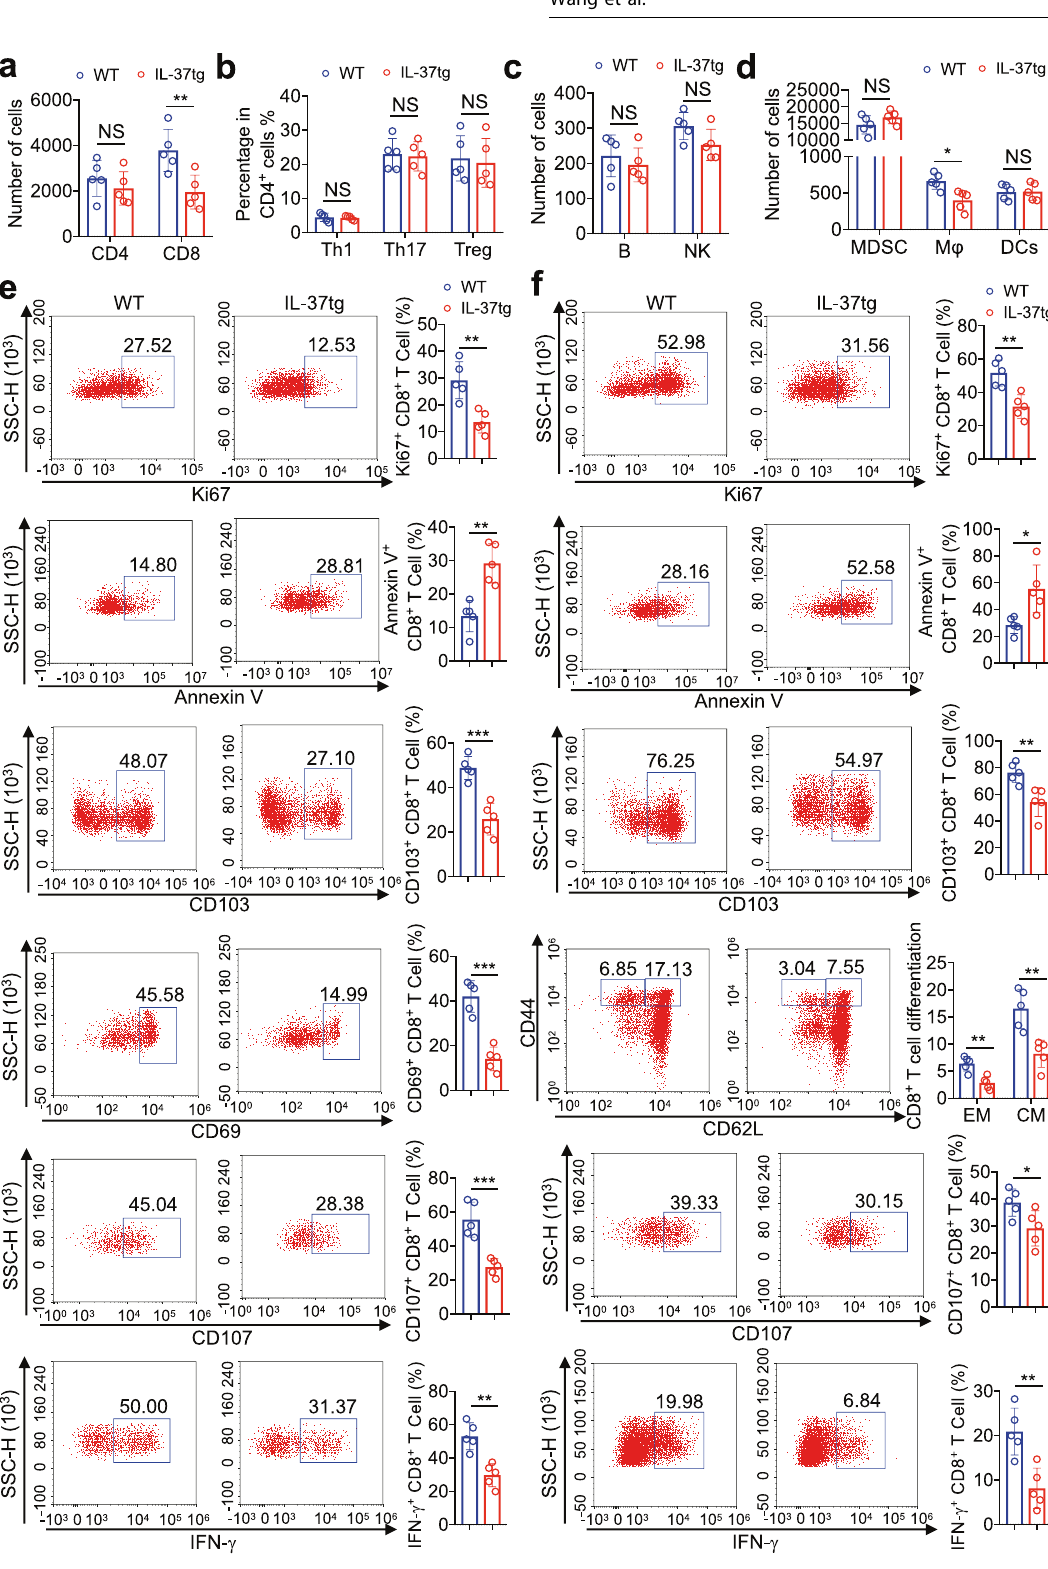
(Supplementary Fig. S4e, f). In addition, LV-IL-37/LoVo nude mice model exhibited similar ki67 expression compared to that in the LV- Ctrl/LoVo group (Supplementary Fig. S4g). LV-IL-37/LoVo cells and LV-Ctrl/LoVo cells have similar c-myc as well as p-p65, pSmad3L and pSmad3C level (Supplementary Fig. S4h, I), although IL-37 inhibited